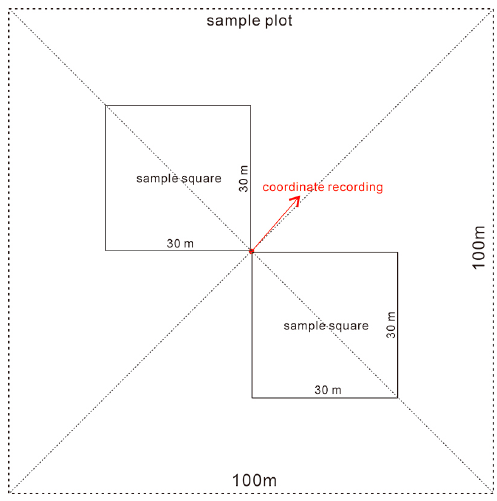
Figure 2. Design of sample plots.